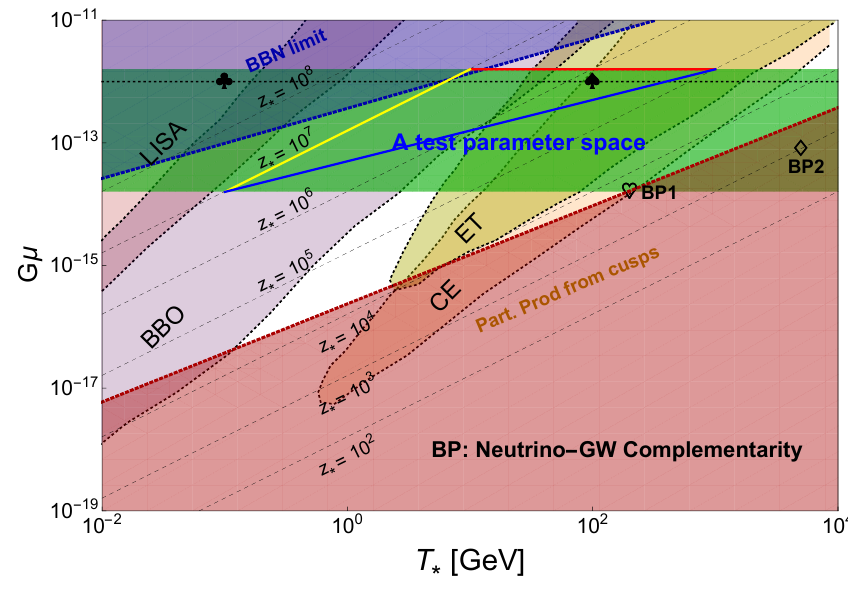
Figure 2 . Gµ vs. T ∗ plot against the sensitivities of various GW